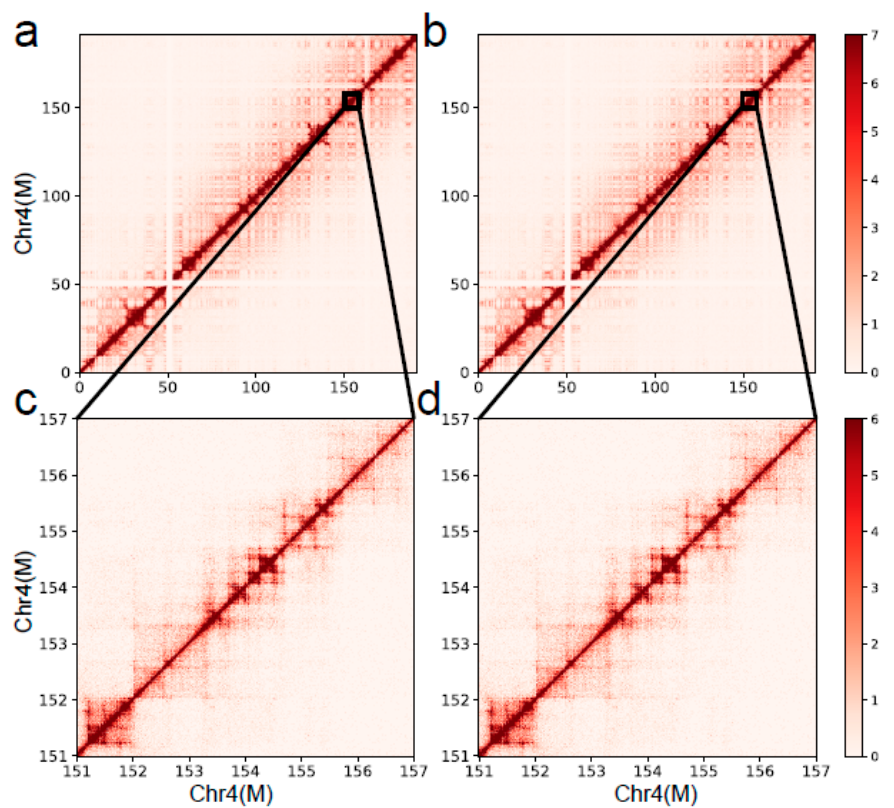
Figure 8. The interaction heatmaps of chromosome 4 from the K562 cell line. ( a and c ) The heatmaps of the whole and local chromosome 4 of K562 generated by the published results. ( b and d ) The interaction heatmaps of chromosome 4 and the enlarged region generated by the DLO Hi-C tool.